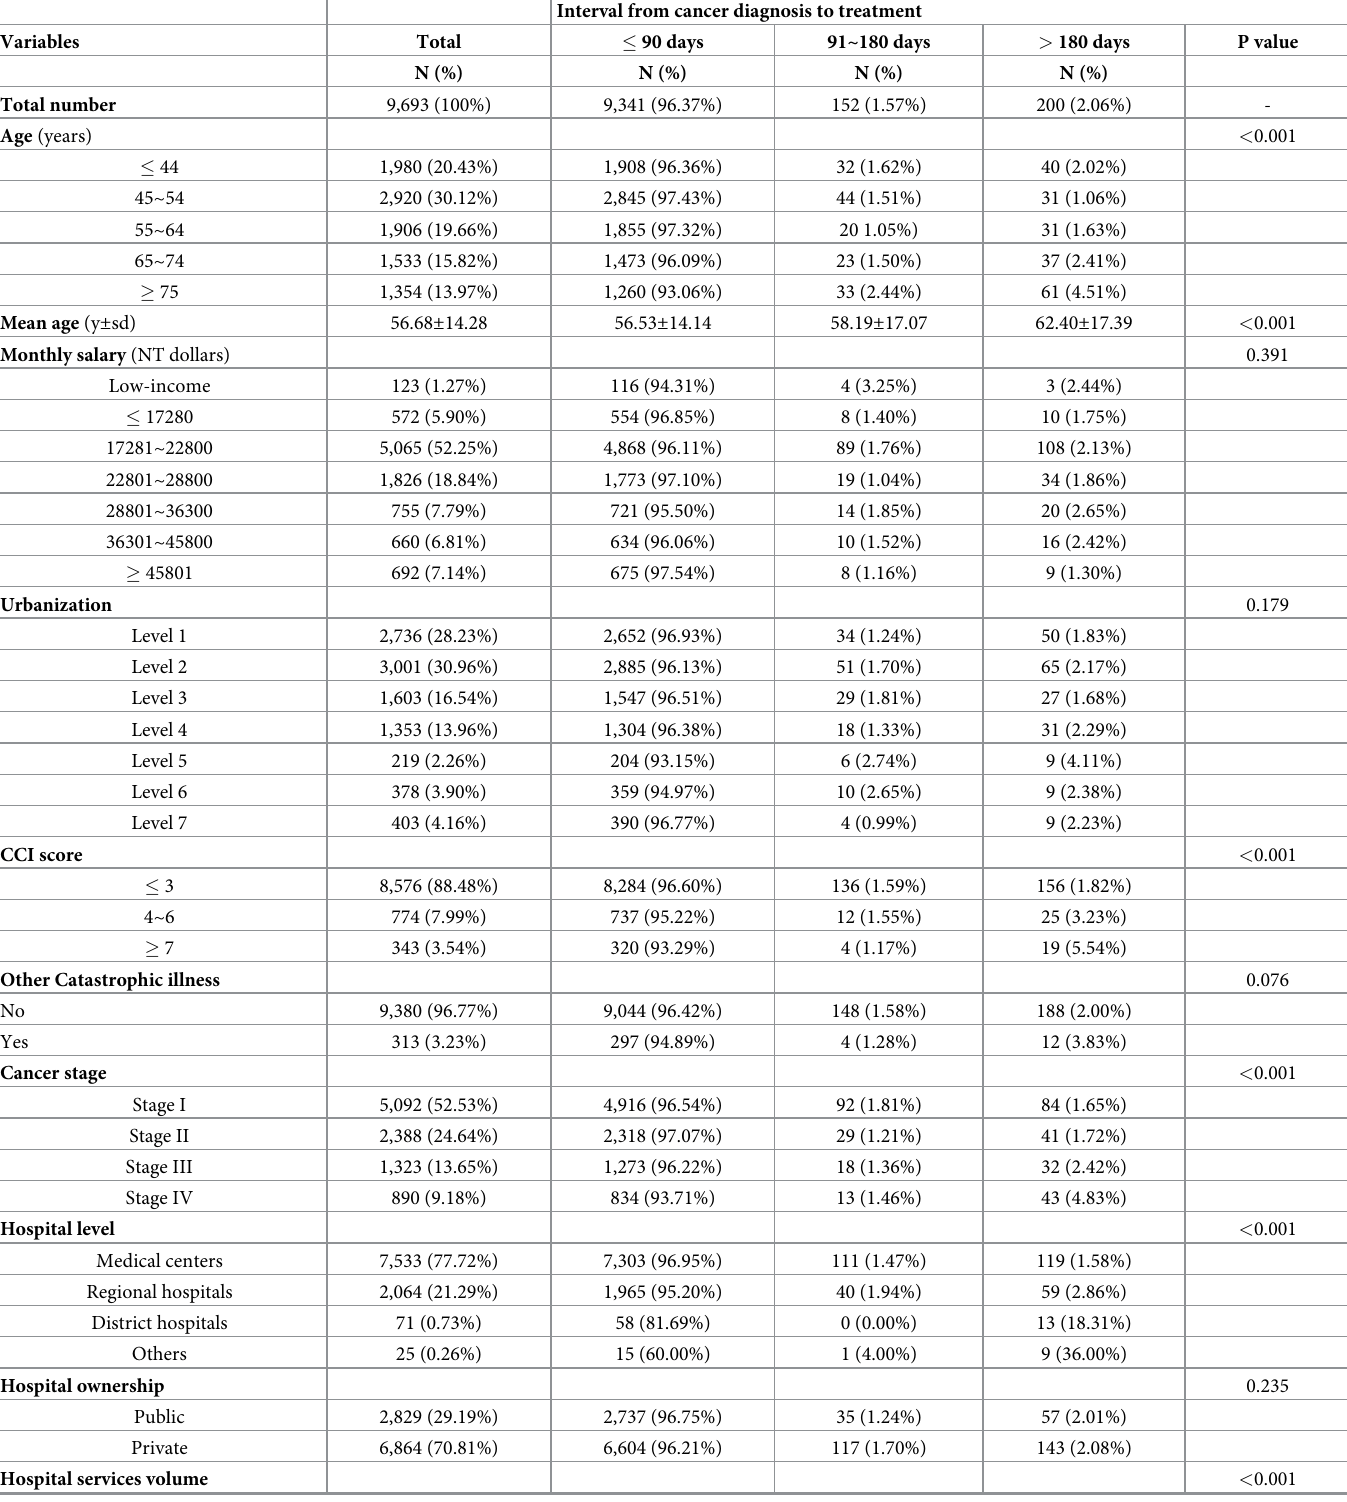
Table 1. Descriptive statistics of cervical cancer patients with different time interval from diagnosis to treatment. Interval from cancer diagnosis to